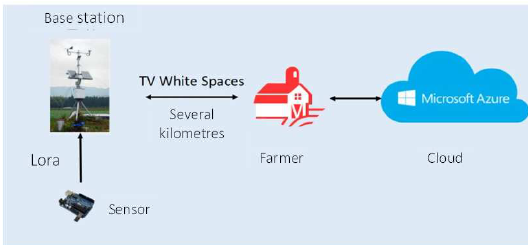
Figure 7. A two-layers data communication architecture from sensors to